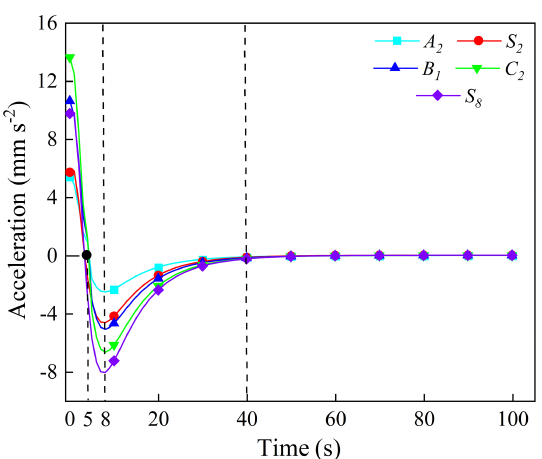
Figure 18. Acceleration